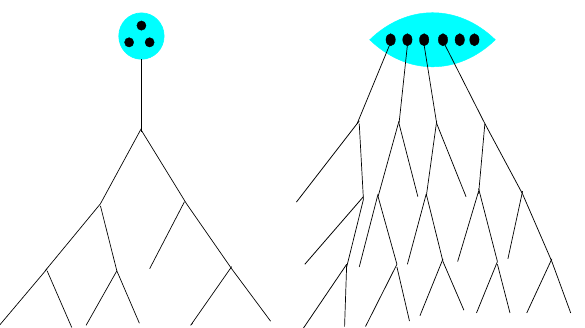
Figure 2. Schematic view of the initial part of the parton cas- cade in the proton. Left: the cascade starts from the same uni- versal parton Fock state; new partons participating in multiple scattering processes emerge from the cascade development, be- ing characterized by 1 / x distributions for the momentum frac- ∝ tion. Right: the proton is represented by a superposition of Fock states consisting of di ff erent numbers of large x constituent par- tons; the more abundant multiple scattering the larger Fock states involved in the